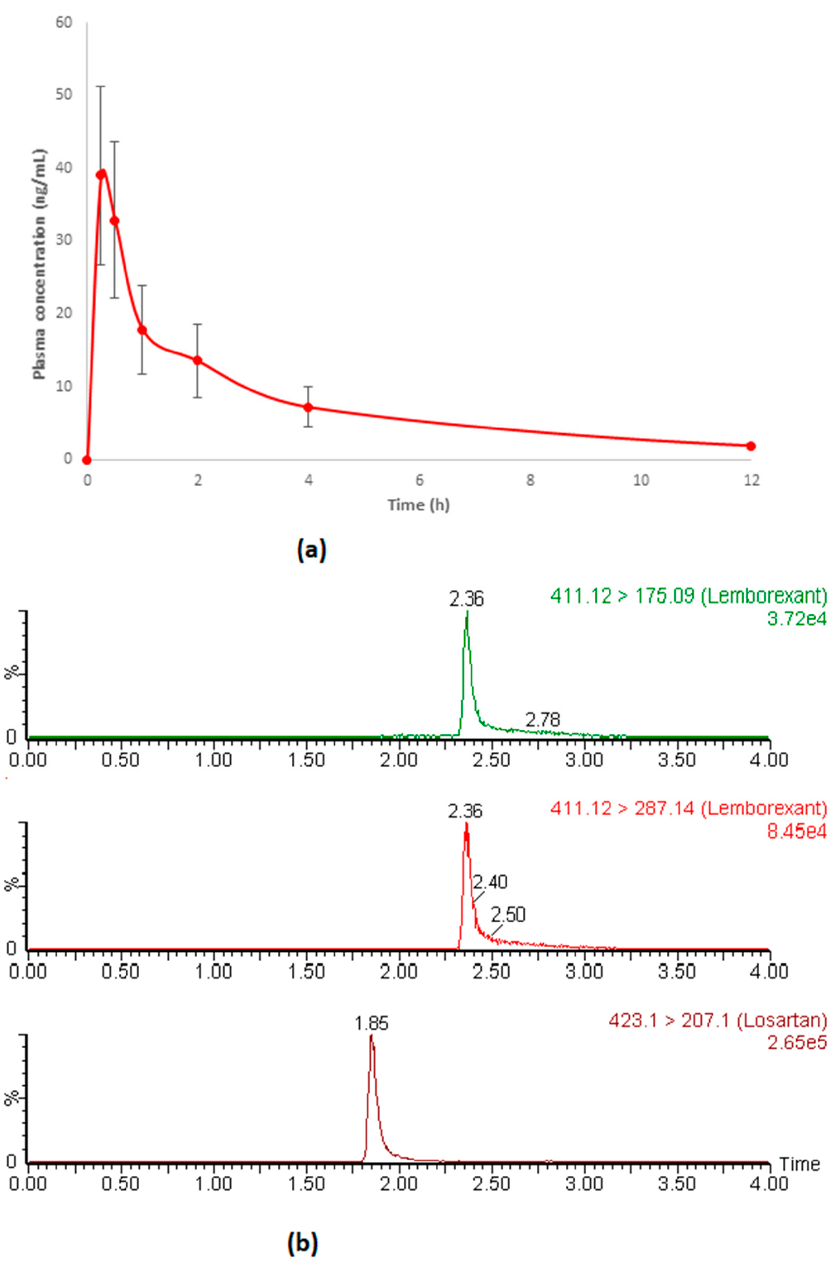
Figure 4. Plasma concentration versus time profile of LEM ( a ) and representative MRM chromatogram of LEM and IS ( b ) in rat after oral administration of 10 mg/kg LEM. [411.12 > 175.09 → Qualifier ion; 411.12 > 287.14 → Quantifier ion; 423.1 > 207.1 → IS].